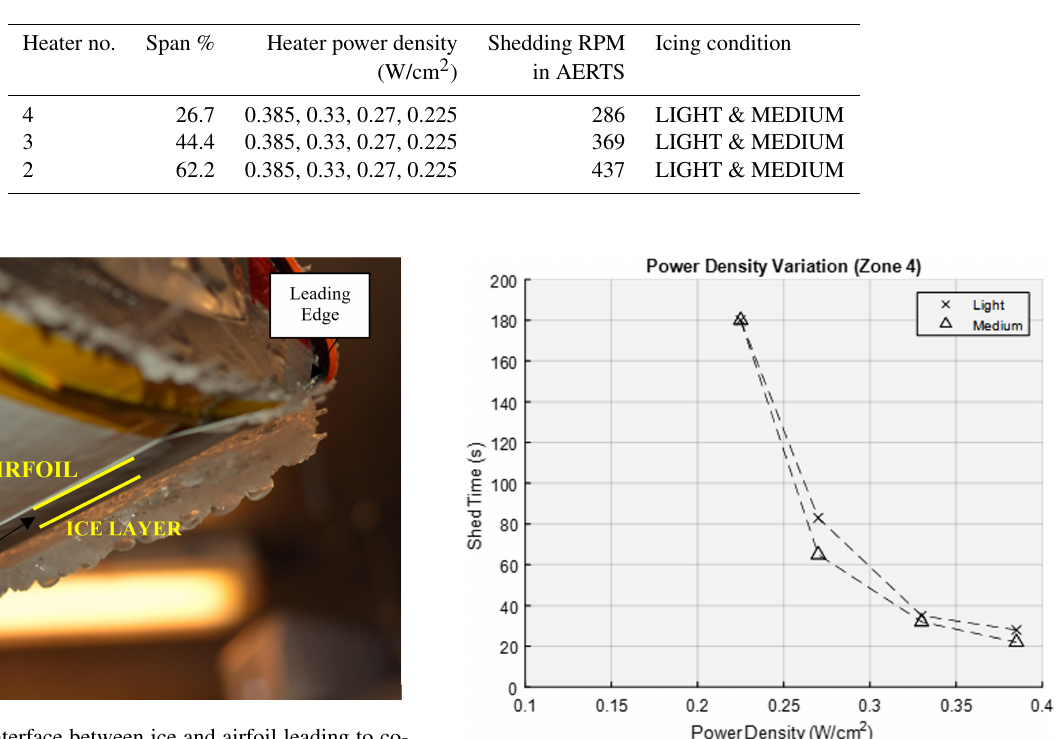
Table 4. Test matrix for deicing IPS power variation.